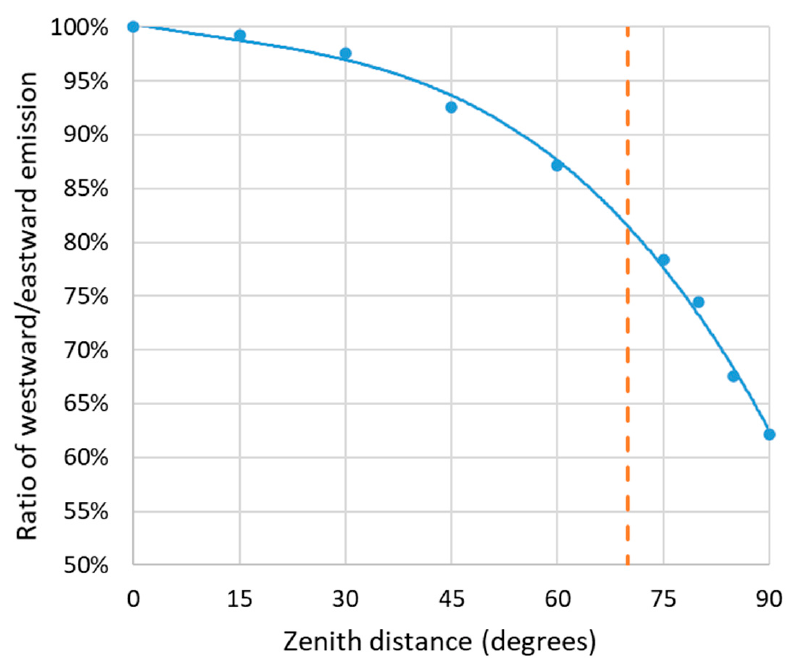
Figure 11. The ratio of westward to eastward emission for the Dublin test area when observations are made at the same zenith distance. The dashed line marks the maximum observation angle of clear-sky VIIRS observations of Dublin made in 2018. Note that, although the points-of-view differ by 180 ◦ and so aligned along the street grid structure, there is an asymmetry in the light output, even at the same zenith distance. For the VIIRS observations, there is an asymmetry in the zenith distance of observations taken at westward and eastward azimuths, with those from the west ranging from 10 ◦ to 50 ◦ , which those from the east ranged from 0 ◦ to 70 ◦ . The asymmetry in the emission function as well as due to the effect of atmospheric airmass and local conditions needs to be considered when analysing such